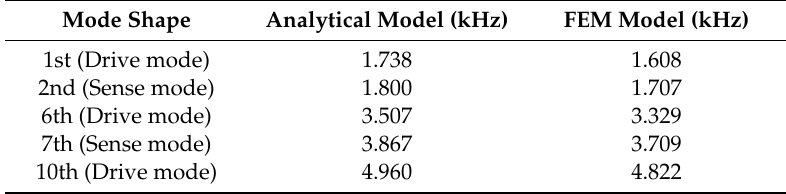
Figure 7. Modal analysis results and the corresponding mode shapes for MEMS gyroscope ( a ) 1st mode (1.607 kHz) ( b ) 2nd mode (1.707 kHz) and ( c ) 6th mode (3.329 kHz) and ( d ) 7th mode (3.709 kHz). Table 3. Comparison of the analytical and FEM analysis-based modal frequency